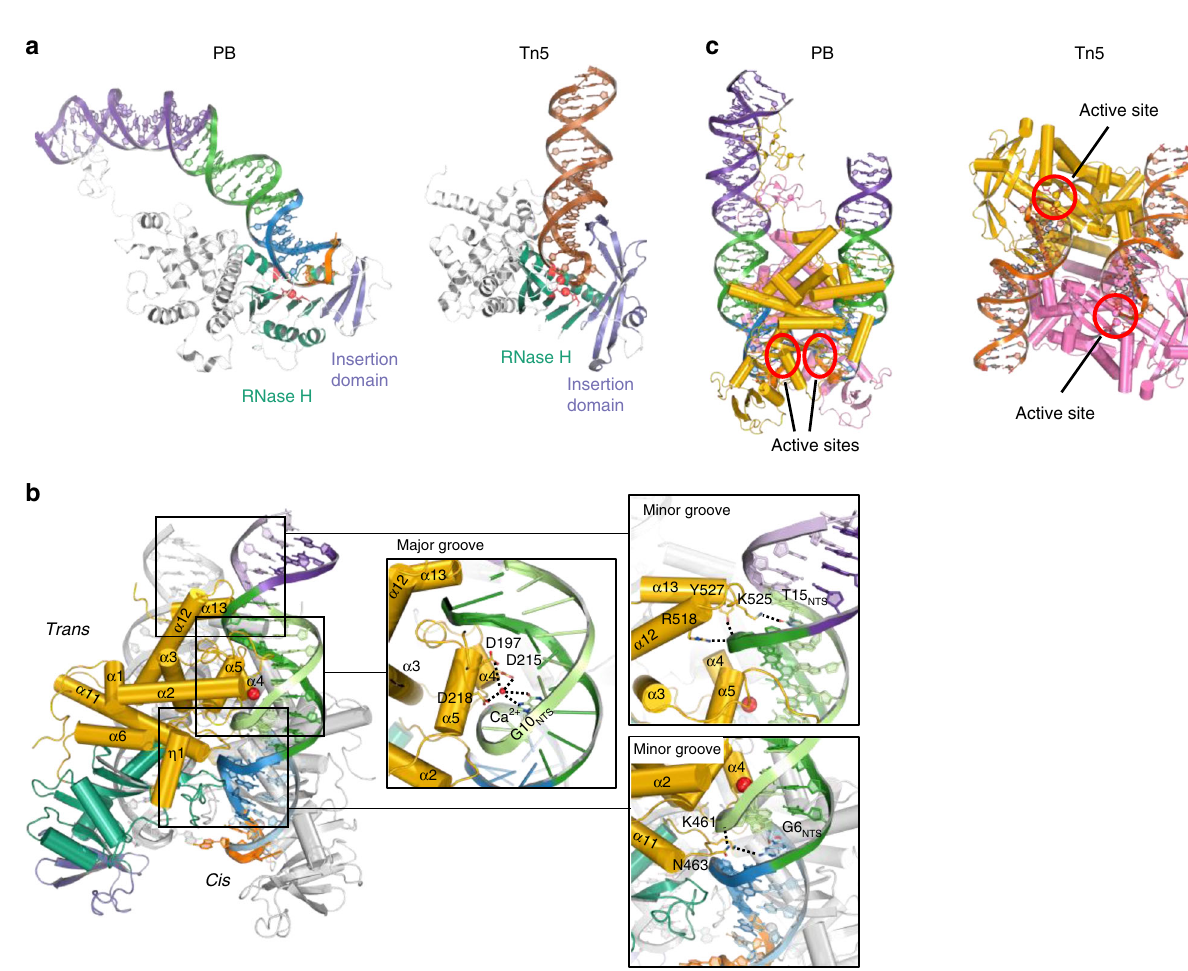
Fig. 2 Comparison of PB and Tn 5 and details of PB TIR recognition. a Comparison of domain organization in PB SNHP and Tn 5 transpososomes. RNaseH- like catalytic domains are in green, with active site residues highlighted in red. Insertion domains are colored in violet. The insertion domain of PB contains fewer β -strands than that of Tn 5 . b The DDBD interacts with LE TIR in trans . The α -helices comprising DDBD widen the major groove of the repeat shown in green. The red sphere is a Ca2 + ion in the DDBD/DNA interface. Other parts are colored as in Fig. 1d. c Comparison of TIR binding by PB (TIR DNAs are parallel; shown for the SNHP complex) and Tn 5 transposase (anti-parallel TIRs; PDB 1MUS). Both transposases demonstrate cis and trans protein/DNA interactions. pB DNA colors are as in Fig. 1d. Tn 5 TIR DNA is brown. Individual monomers are shown in yellow and pink. Active site locations are indicated